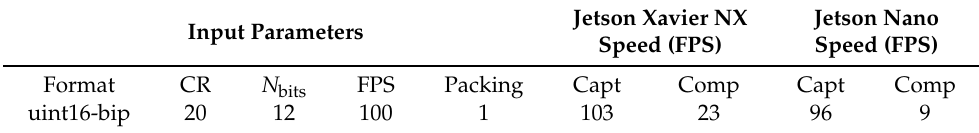
Table 5. Compression speed without using